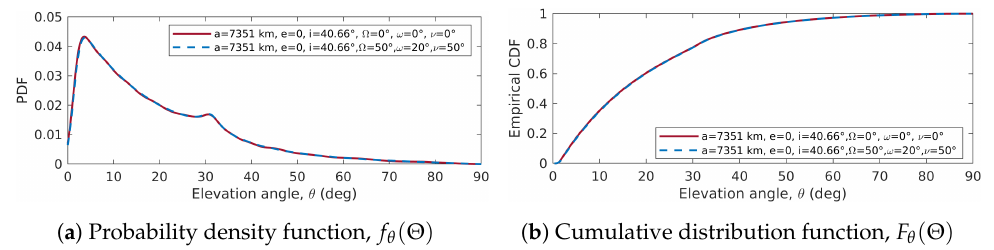
Figure 12. PDF and CDF for two orbit configurations sharing the same altitude, eccentricity, and orbit inclination, but with the remaining orbital parameters being different.